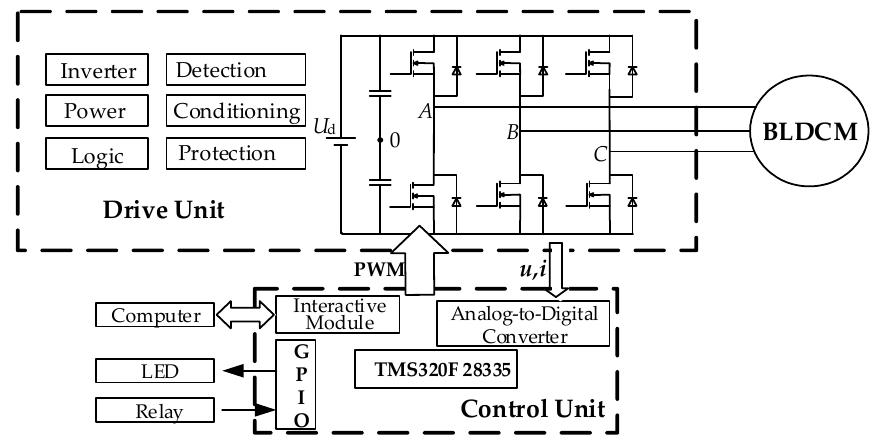
Figure 22. The structure of the controller. GPIO: general purpose input/output. LED: light-emitting diode.